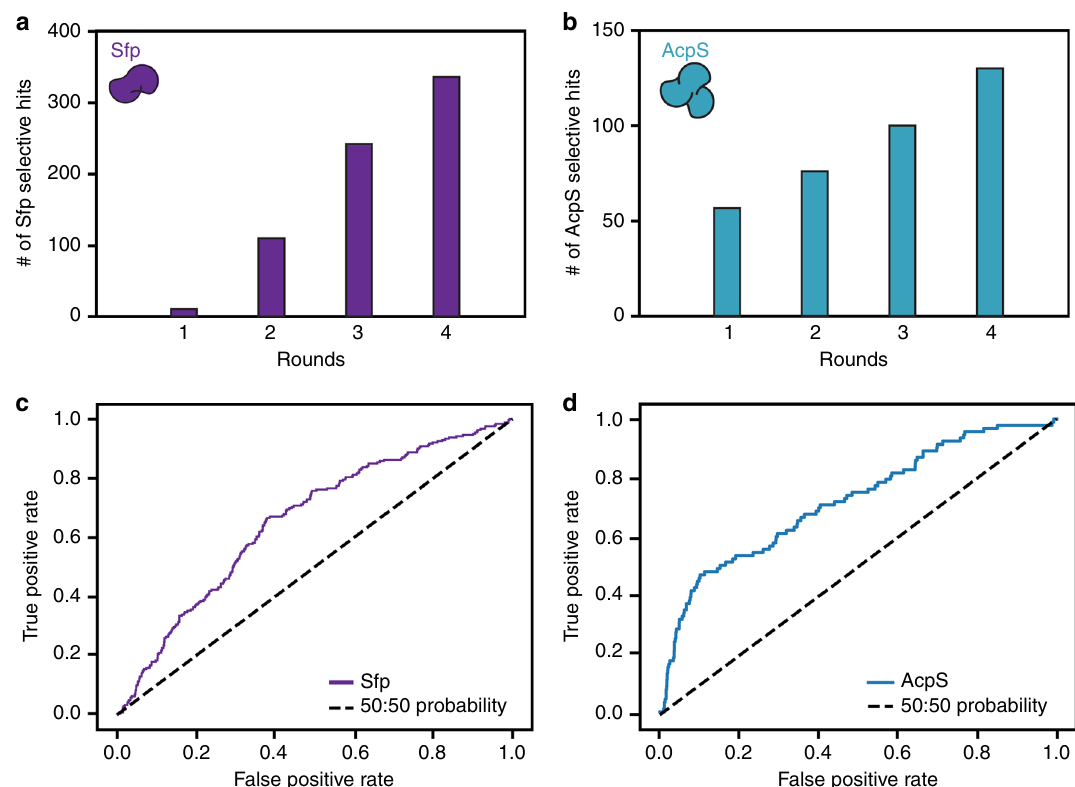
Fig. 2 Speci fi c peptide hits identi fi ed by POOL and model validation. The number of peptides with speci fi c labeling for Sfp (purple bar graph) ( a ) and AcpS (cyan bar graph) ( b ) over four rounds. The receiver operating characteristic (ROC) curve plot for both Sfp (purple curve) ( c ) and AcpS (cyan curve) ( d ) selective labeling, which diagnoses POOL ’ s ability to predict hit peptide substrates. The dashed line is the baseline that indicates the performance of a hypothetical random model without prediction